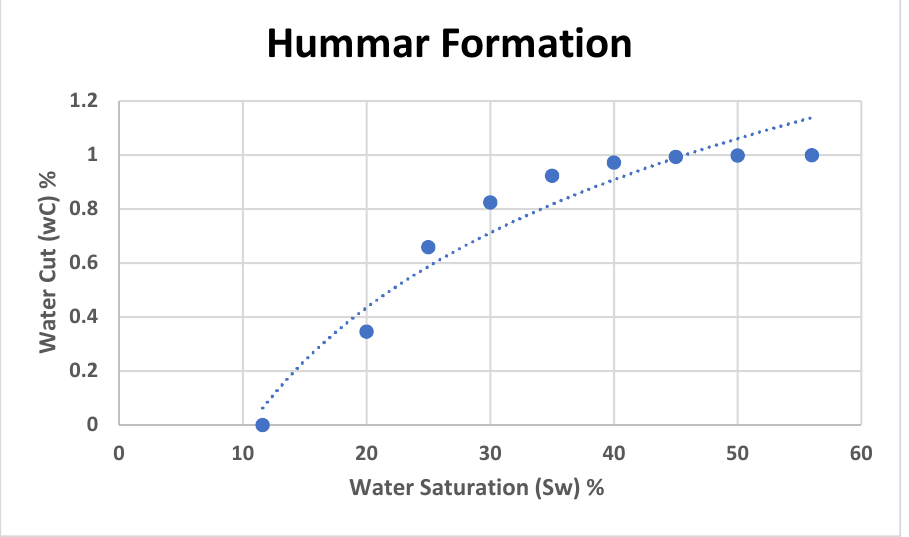
Figure 11. Fractional flow or water cut diagram curve with water saturation for the displacement from oil by water.